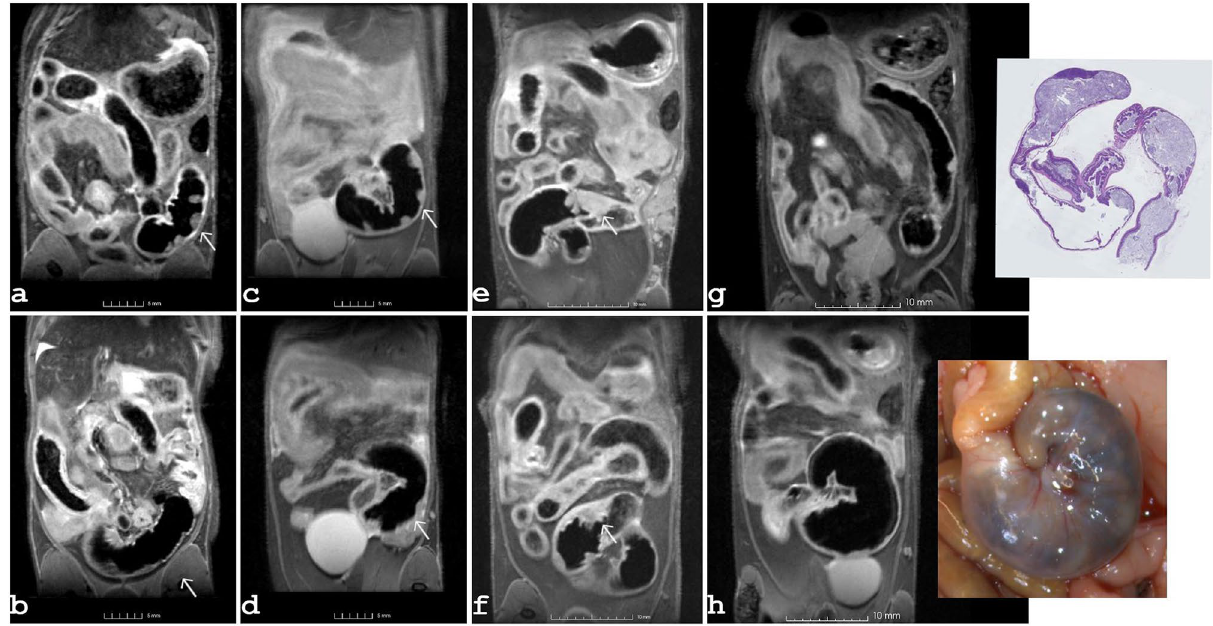
Figure 3. Examples of the development of the Peyer´s patches are given for a mutant female ( a , b ) and a male mutant ( c , d ) at an age of six and eight months. A comparison between the first and the second row illustrates the decreasing visibility of the patches at later time points. A striking thickening of the cecal wall was noted with increasing age, as observed, for example, in two female mutants at 12 months of age ( e , f ) (thickening is indicated by an arrow). ( g ) an example of the observed Peyer’s patches detected in a control along with associated histology. ( h ) coronal image showing the enlarged cecum of a mutant, and the corresponding macro image.